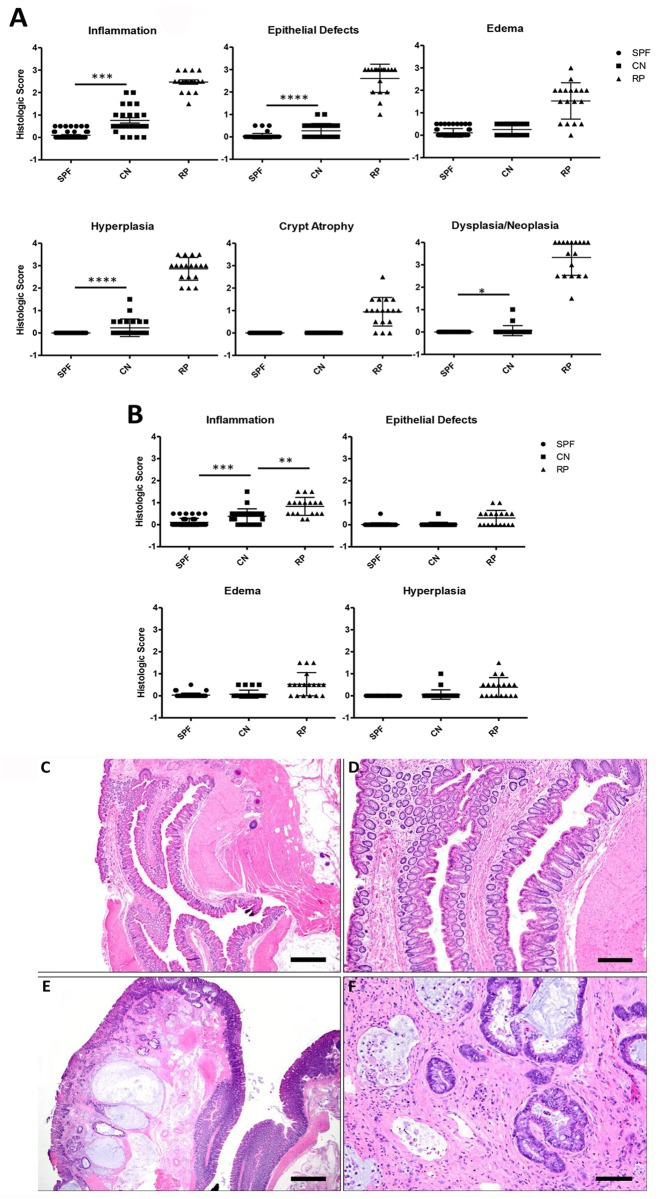
(A) Comparison of Rectal/Colo-rectal Junction Histologic Scores. (B) Comparison of Distal Colon Histologic Scores. (C-F) Comparison of Histology Observed in Clinically Normal Lpd Mice (C&D) vs RP Lpd Mice (E&F). In the low and high magnification images of a representative clinically normal animal, the non- prolapsed rectum and colon are normal without any significant inflammation or other changes like hyperplasia or dysplasia. The low magnification image (E) of the clinically affected animal shows marked expansion of the prolapsed rectum and adjacent distal colon by inflammation, edema, glandular hyperplasia, and high grade dysplasia/neoplasia. High magnification of the prolapsed rectum (F) showing carcinomatous glands that have invaded deep into the underlying musculature. (Bar lengths = C: 400μm; D: 150μm; E: 400μm; F: 75μm).